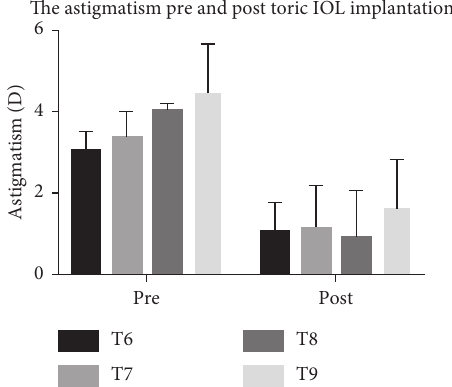
Figure 1: The astigmatism of patients with moderate-to-high corneal astigmatism pre- and posttoric IOL